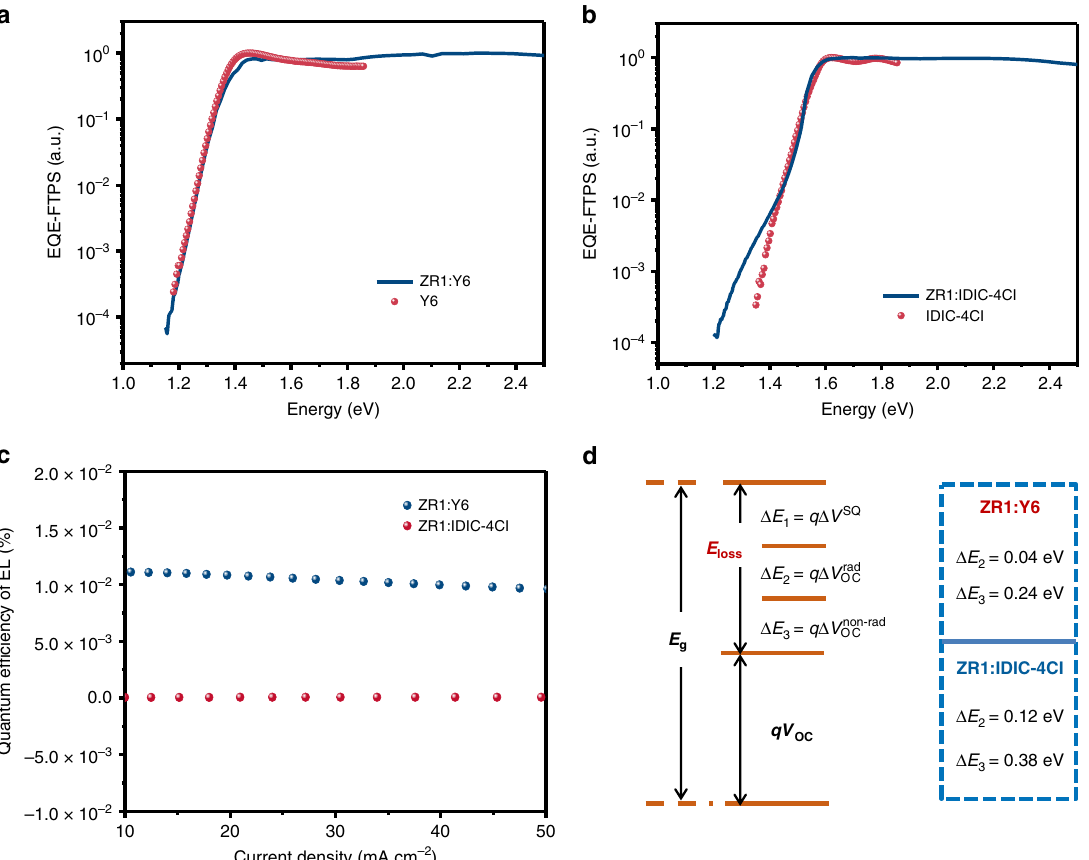
Fig. 4 Quanti fi cation of the energy losses. a , b Fourier-transform photocurrent spectroscopy of ZR1:Y6, ZR1:IDIC-4Cl blend and corresponding single component solar cell. c The electroluminescence quantum ef fi ciency of ZR1:Y6 and ZR1:IDIC-4Cl blend solar cells at different injected currents. d Schematic diagram for energy loss of ZR1:Y6 and ZR1:IDIC-4Cl blend solar